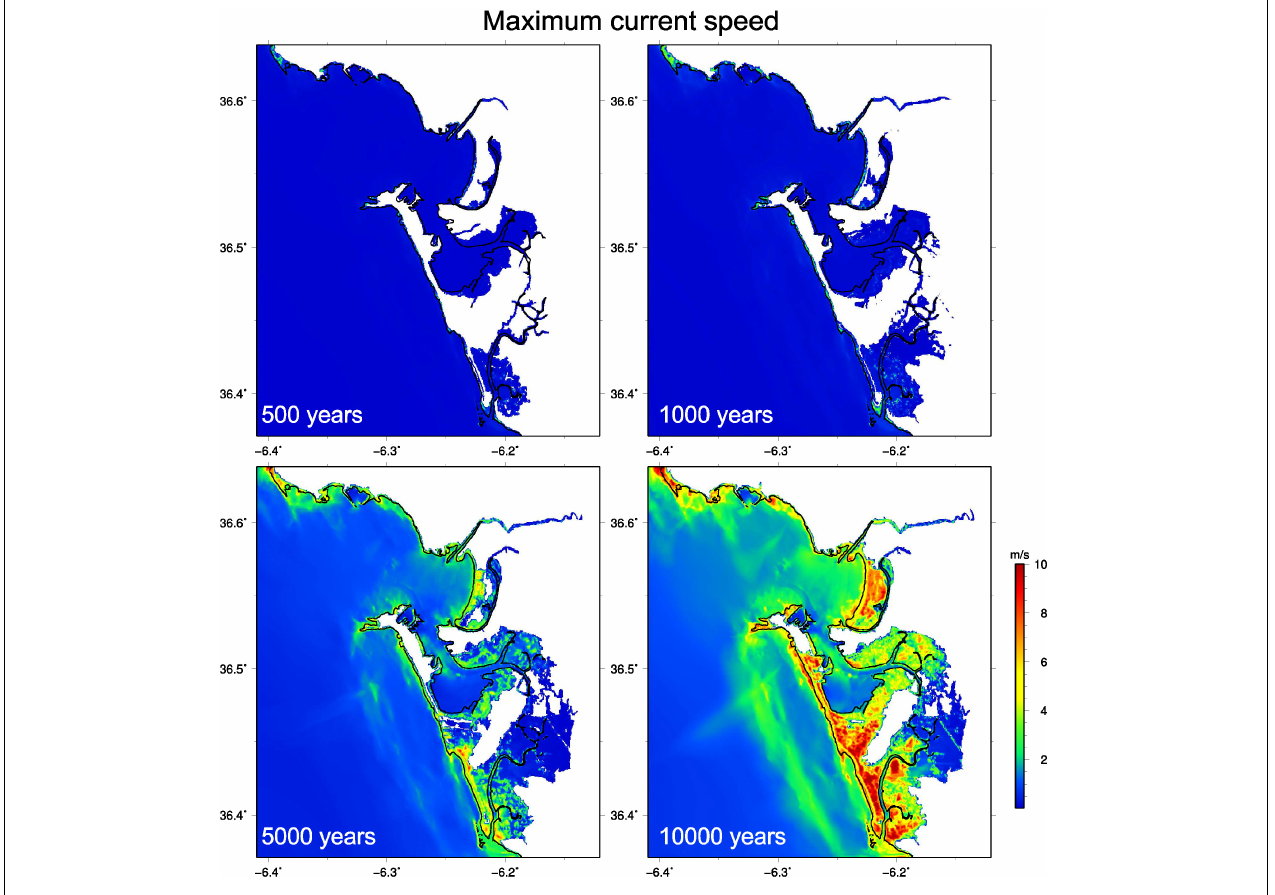
FIGURE 11 | Maximum current speed for different return periods. 99% confidence